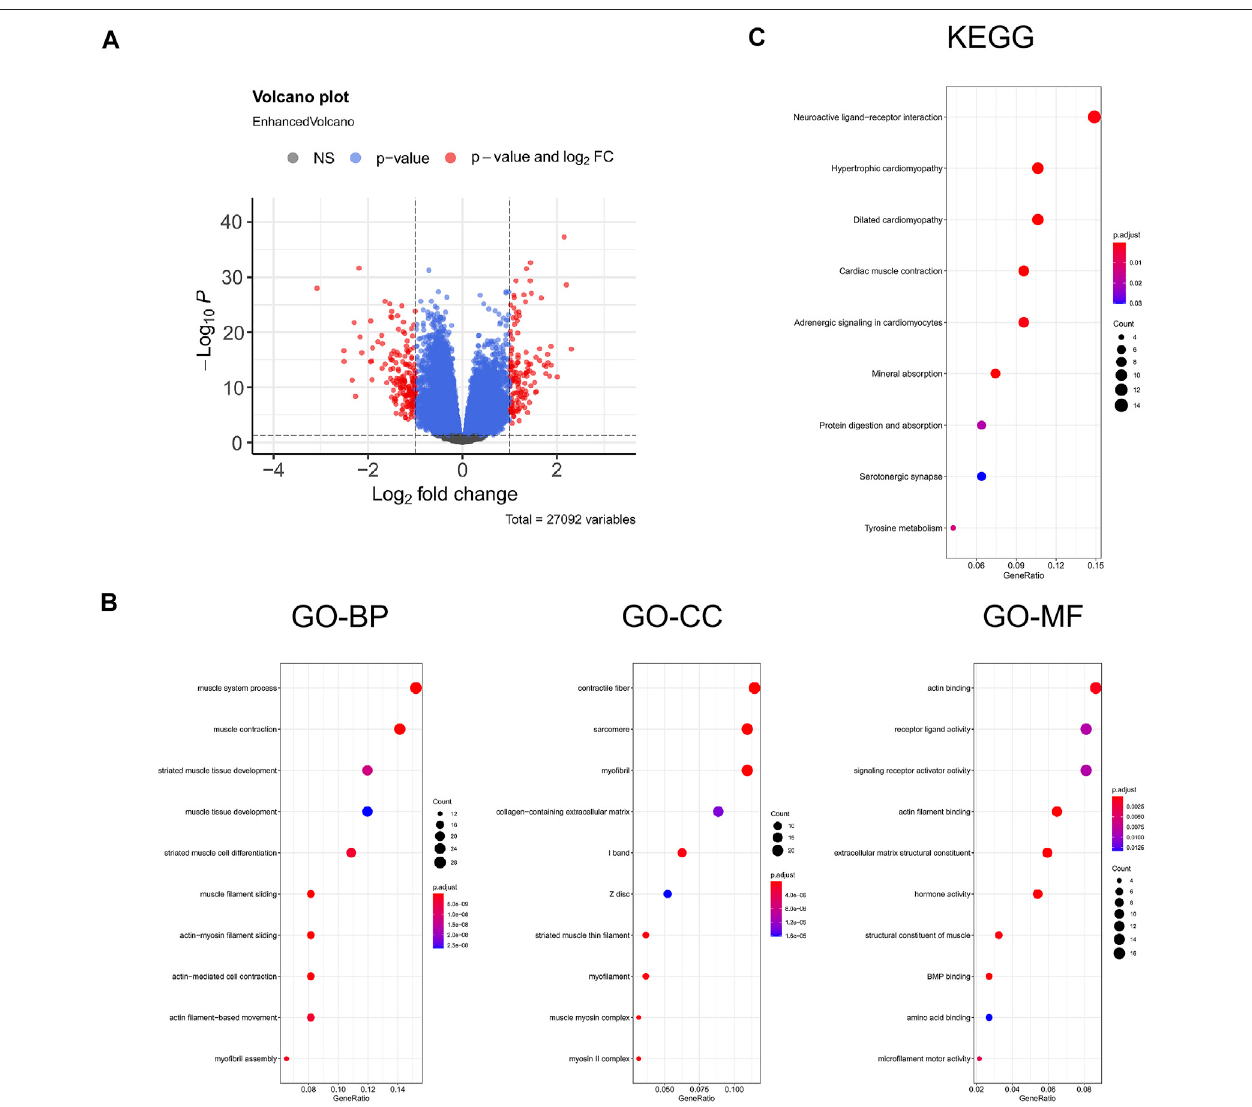
FIGURE4| EnrichmentanalysisfortheDEGs. (A) VolcanoplotofDEGs,redrepresentsthefoldchangeand p -valuemeetstheconditions,andbluerepresentsthat only p -value meets a condition; (B) GO functional analysis; (C) KEGG pathway. GeneRatio represents the ratio of enriched genes to inputted genes, BP represents biological processes, CC represents cellular component, and MF represents molecular